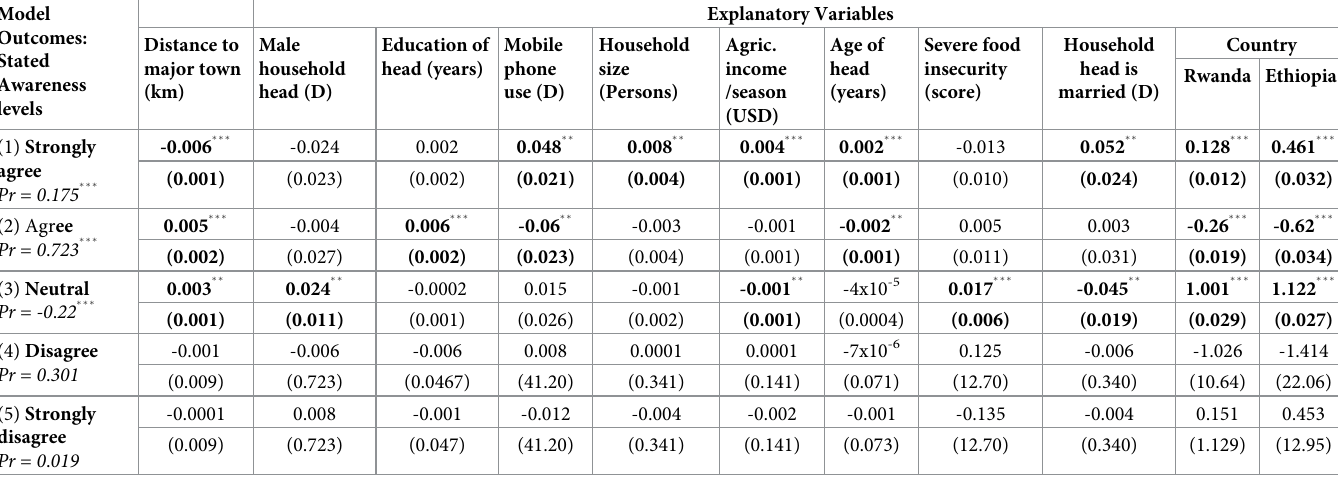
Table 5. Marginal effects after generalized ordered logit for awareness on CBE practices. Model Outcomes: